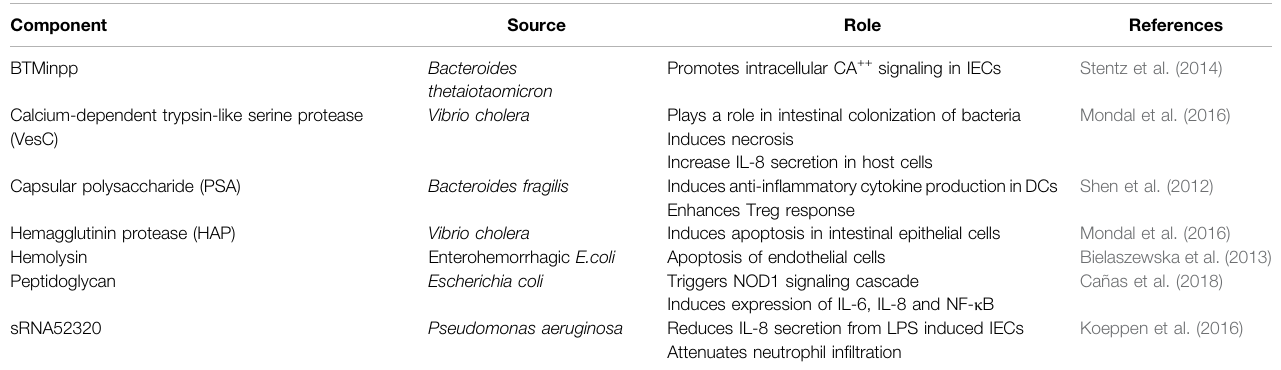
TABLE 2 | Source and function of different bacterial outer membrane vesicle components in IBD.